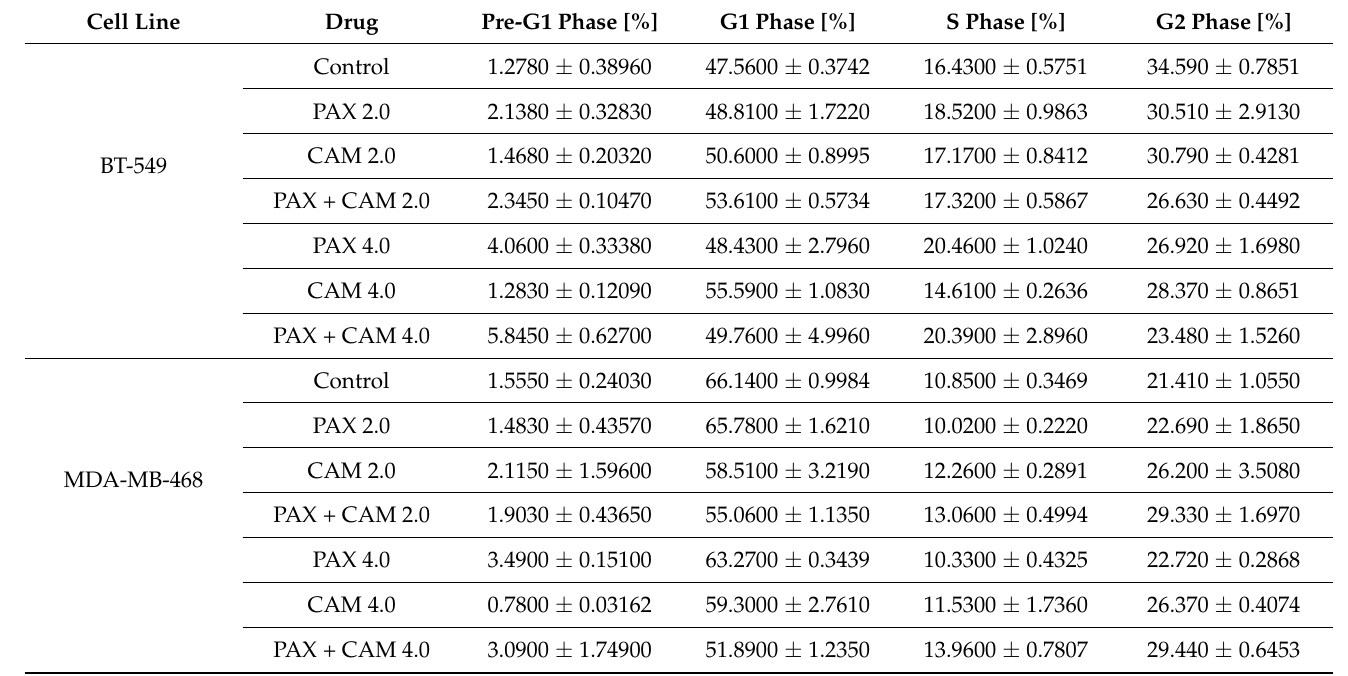
Table 3. Cell cycle distribution of BT-549 and MDA-MB-468 TNBC cells exposed to an individual or concomitant CAM and PAX treatment for 48 h using selected ratios (2.0 = IC 50 , 4.0 = 2IC 50 ) of the IC 50 determined in the MTT assay, stained with propidium iodide (PI) and analyzed by FACS. The data in the table are presented as the means ± standard deviation ( ± SD) of the